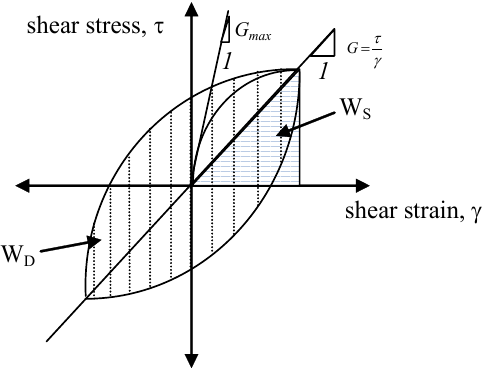
Fig. 6. Concept of the shear modulus and the material damping ratio in the torsional shear test ( W D – the area of the stippled hysteresis loop, W S – the area of the lined triangle) (Zhang et al.